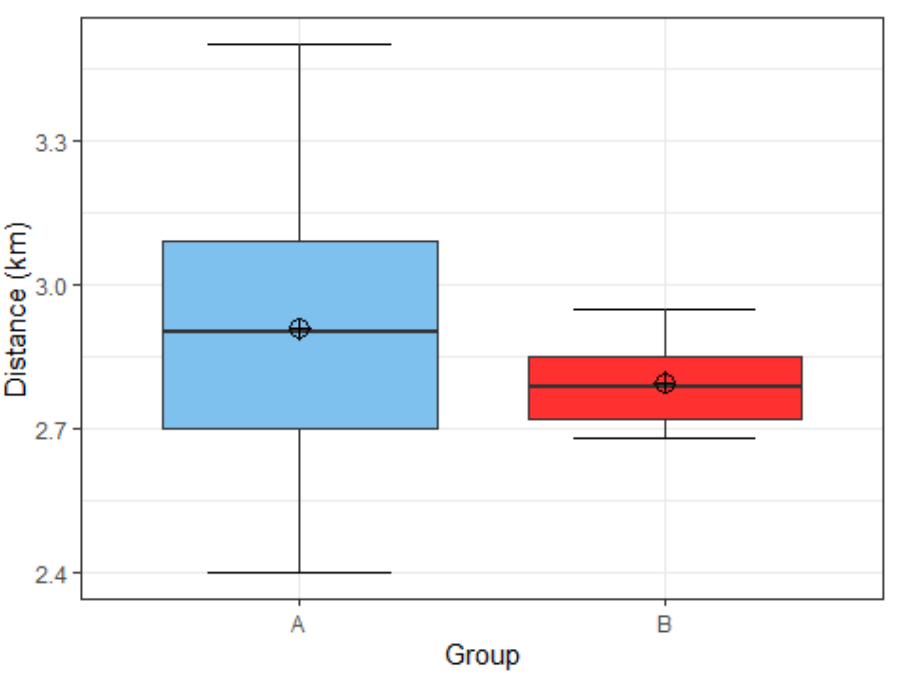
Figure 20. Distribution of distance covered in the Cooper test by group A ( n = 9) and group B ( n = 6). Group A: energy availability ≥ 30 kcal/kg FFM. Group B: energy availability <30 kcal/kg FFM.